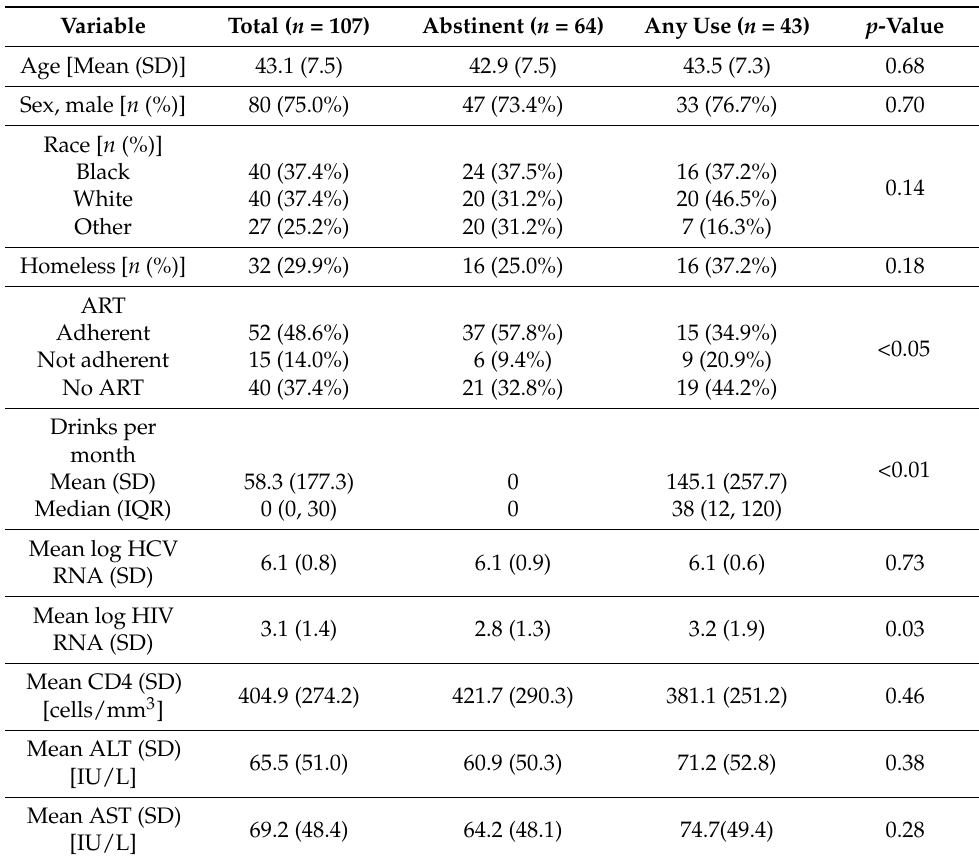
Table 1. Characteristics of study participants–HIV/HCV coinfected persons with current or past unhealthy alcohol